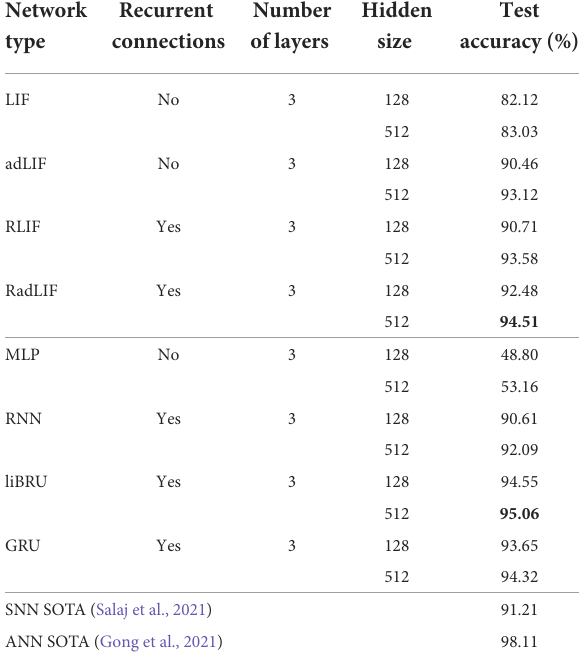
TABLE 7 Results on the SSC dataset. TABLE 8 Results on the SC